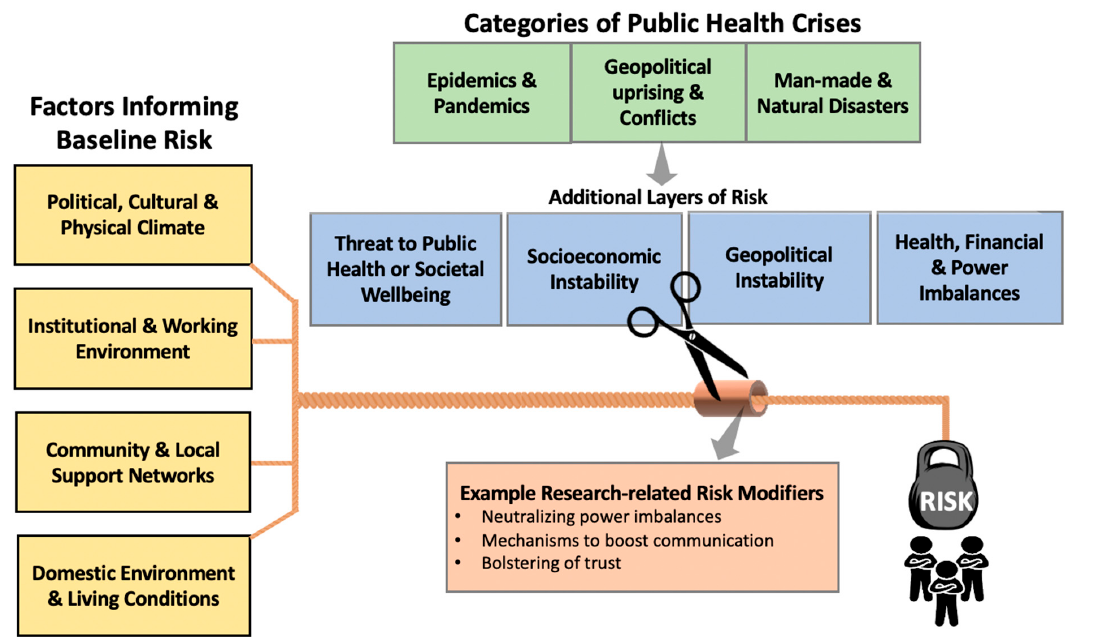
Figure 1. Conceptual model of contributors and potential modifiers to researchers and research staff risk. Beginning from the left of the figure, the yellow boxes are categories of baseline risk that are represented as individual threads that form a rope. Various threats (and protections) to the rope are encountered that translate to risk for a research team. “Risk” in this model is depicted as a weight suspended over the research team by the metaphorical rope. Beyond the strength of the rope derived from the thickness or thinness of its individual threads, the integrity of the rope may be compromised by “cuts” occurring in the setting of public health crises depicted in the green horizontal boxes, which lead to additional layers of risk described within the row of blue boxes and are represented as scissors. Just as these additional layers of risk threaten to cut the rope, protective factors—represented by a sheath—safeguard the rope from being cut. Examples of such risk modifiers are listed within the orange